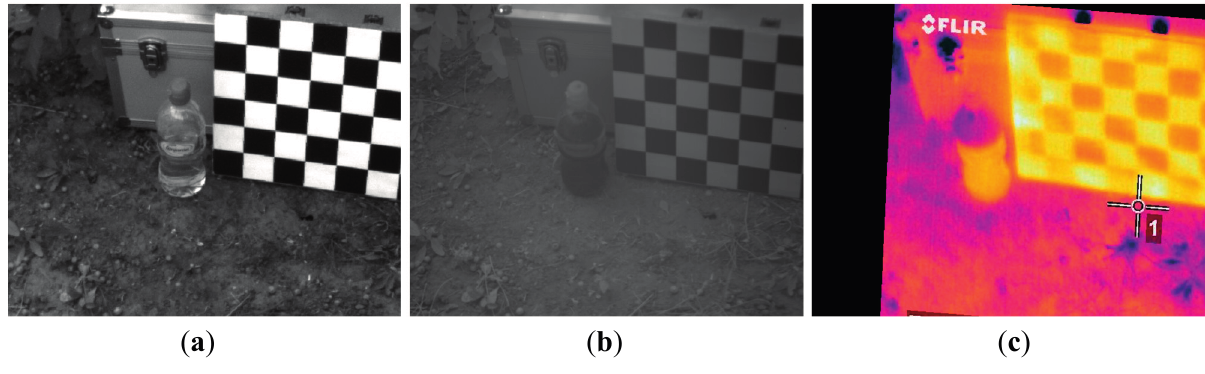
Figure 5. Registered images. ( a ) Registered monochrome image; ( b ) Registered SWIR image; ( c ) Registered LWIR